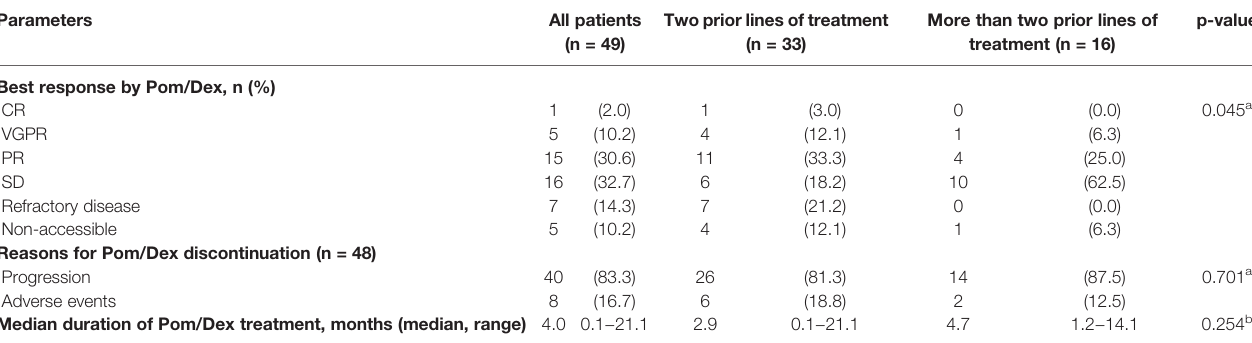
TABLE 2 | Outcome comparison among patients who received two and more than two prior therapies. Parameters All patients